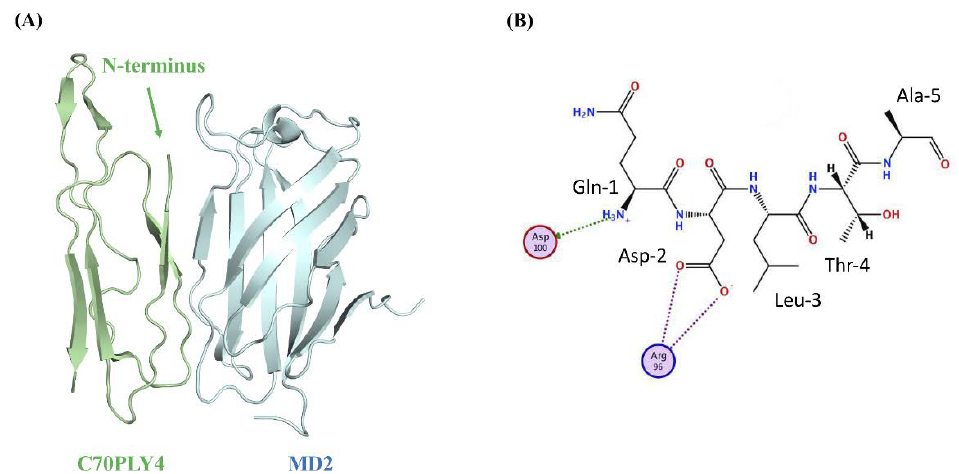
Figure 4. Protein docking simulation predicts the structure of C70PLY4 and MD2 interaction. ( A ) The structures of C70PLY4 and MD2 are shown in green and blue, respectively. The N-terminus of C70PLY4 is indicated. ( B ) The basic and acidic residues of MD2 are indicated by blue and red circles, respectively. The solvent and ionic interactions are indicated by green arrows and purple dotted lines, respectively. The residue numbers of C70PLY4 are indicated.